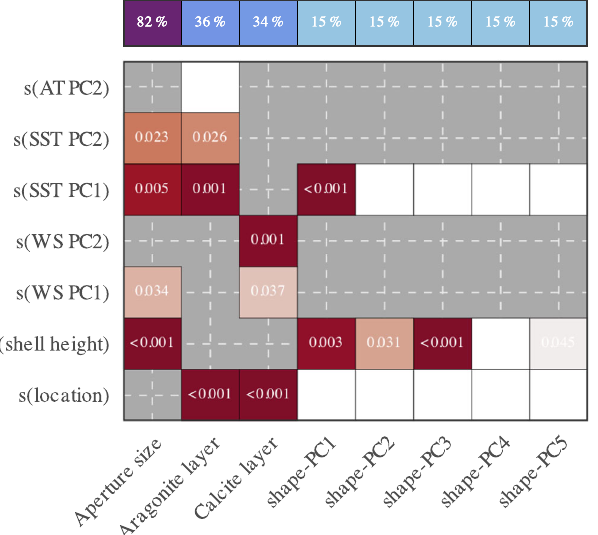
Fig. 6 Correlation matrix of comparative time series analyses. Correlation matrix of comparative model outputs for selected shell characteristics. y - axis shows model terms and x -axis represents the dependent variables (shell shape and thickness descriptors). Colour intensity (gradient) re fl ects the signi fi cance of correlation given by the models' p -values; with darker colours representing lower p -values. Included but non-signi fi cant model terms ( p > 0.05) are represented by blanks. The upper bar shows the deviance explained per model in per cent. Colour intensity re fl ects the amount of deviance explained, with darker colours referring to a higher percentage of deviance explained. The variable s(AT PC1) was not included in any of the models and was thus omitted from the graphic.